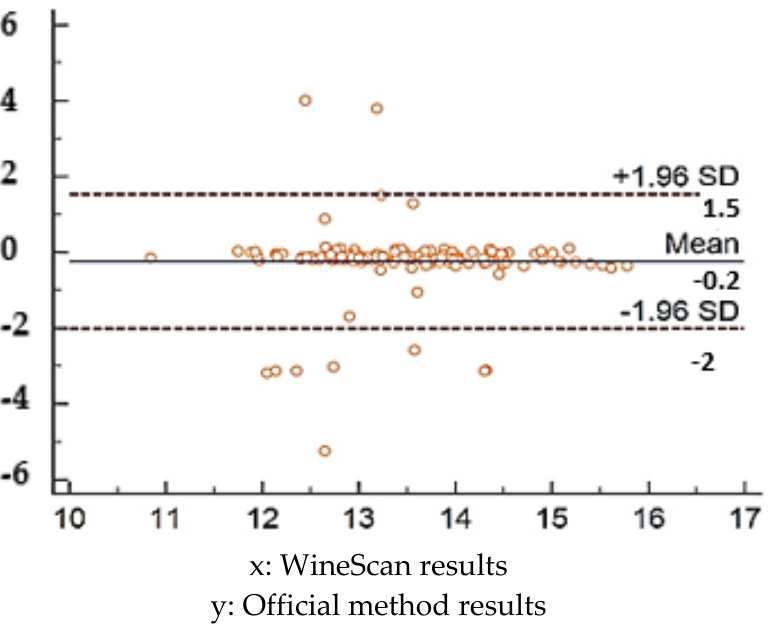
Figure 8. Bland–Altman Test of alcohol concentration results obtained by the official method and WineScan technology. The dashed line represents the regression confidence. The continuous line represents the interval limits.